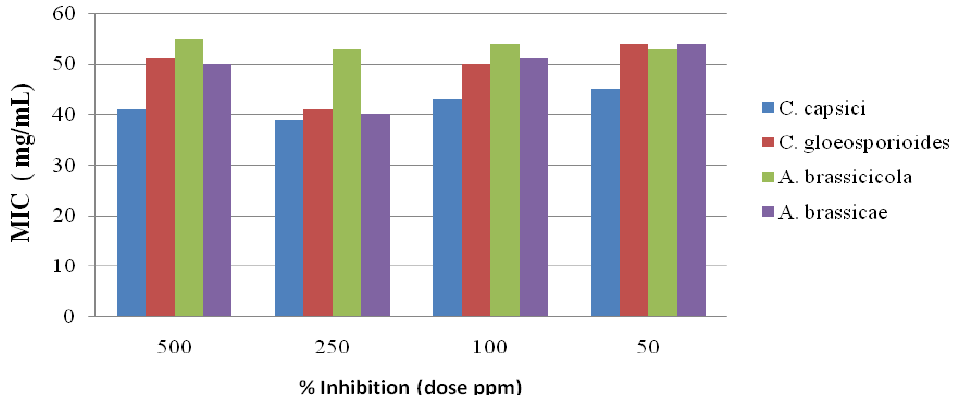
Figure 2. Antifungal results for compound 5a .